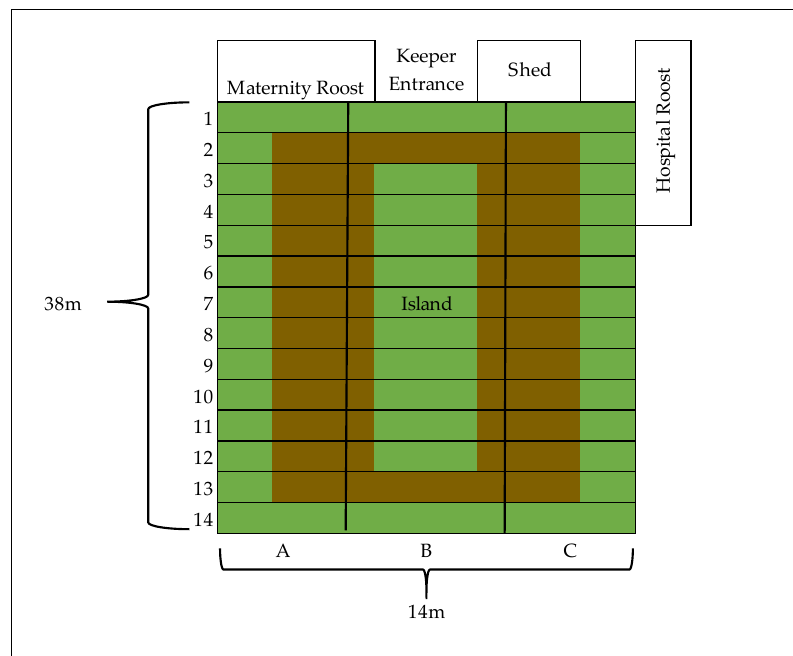
Figure A1. Aerial representation of the “Islands Bat Roost” at Jersey Zoo. Green sections represent accessible keeper walkways. Brown sections denote the 1.5 m deep trench dug to maximize flight paths. The enclosure was divided into 42 approximately equal sections (approximately 4.67 m wide × 2.7 m long) for data collection. These sections, bordered by pre-existing structural poles within the enclosure, were each assigned a letter A–C (west to east) and a number 1–14 (north to south).